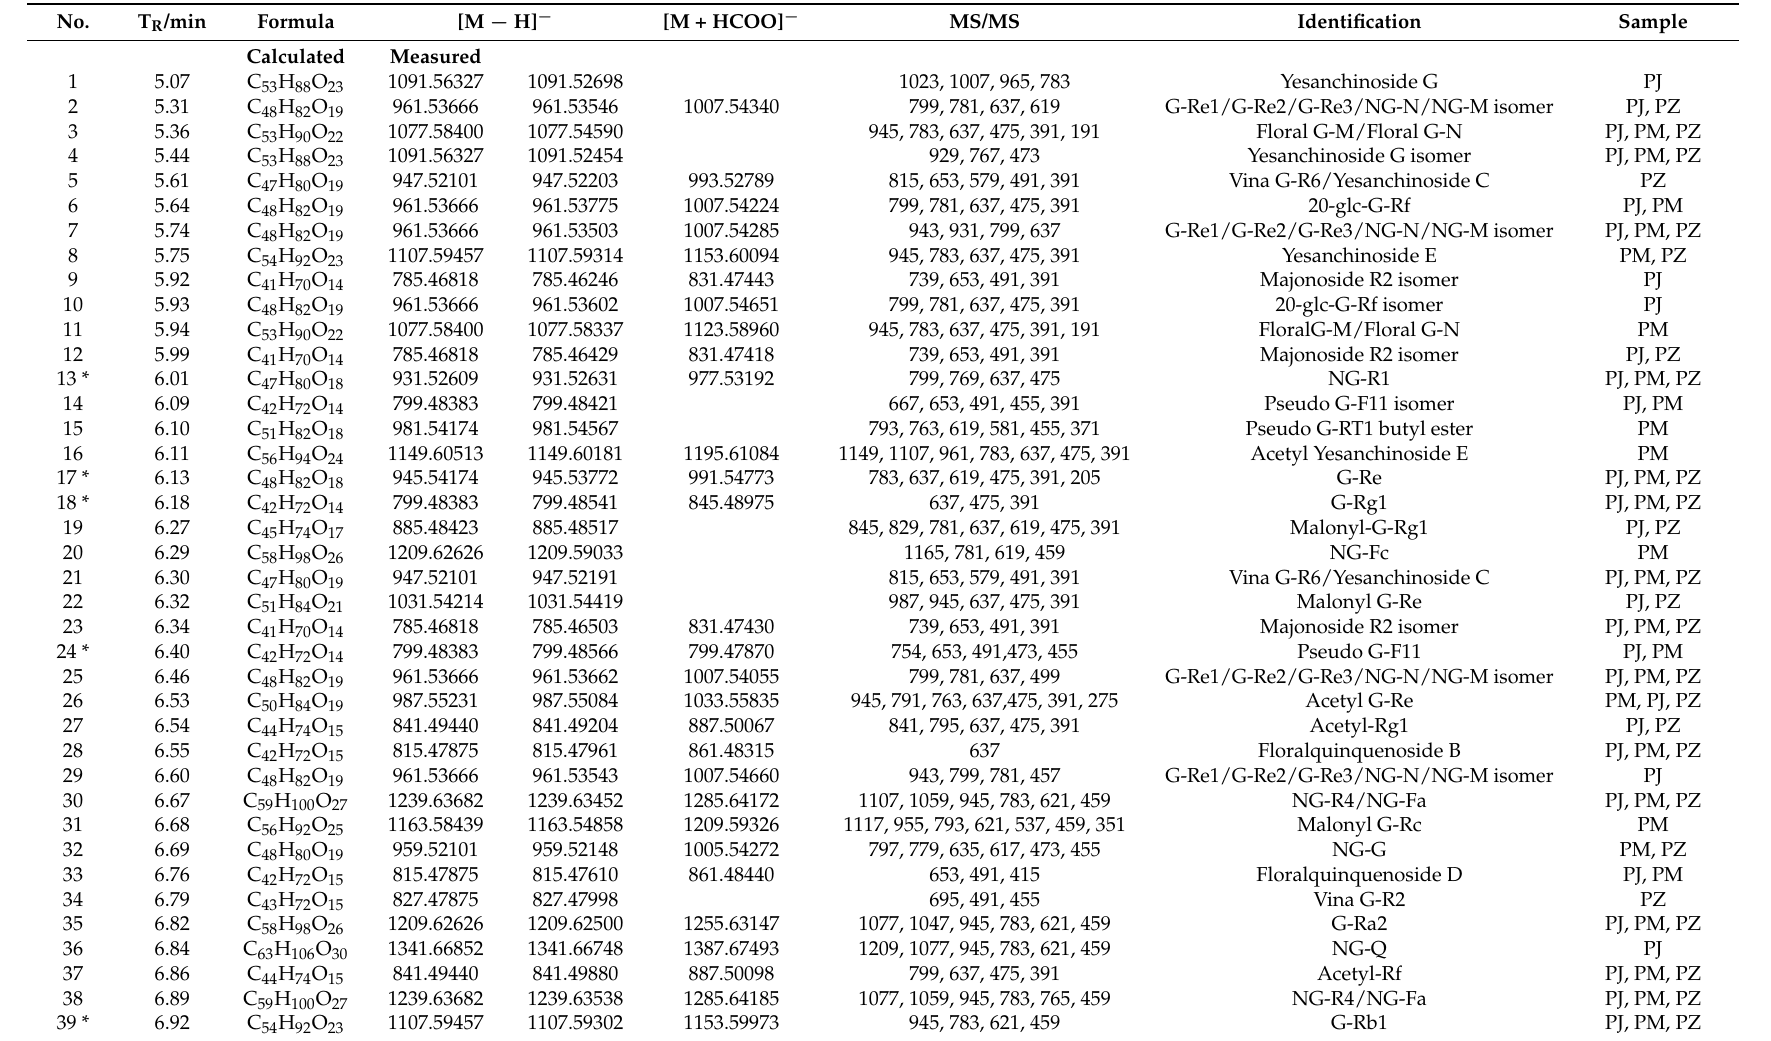
Table 3. Characterization of compounds using UPLC-Q-Exactive/MS (PJ, Panax japonicas ; PM, Panax japonicus var. major; PZ, Panax zingiberensis ).